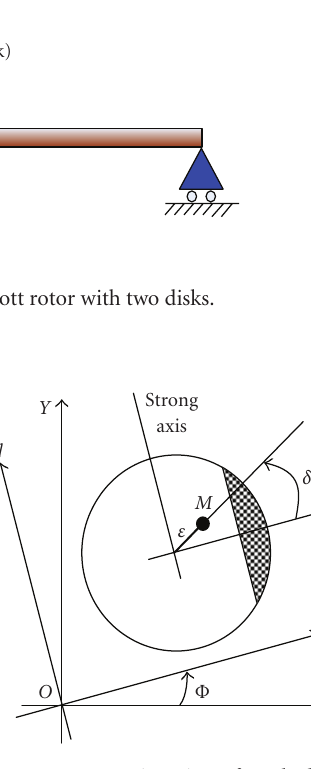
Figure 2: Section view of cracked